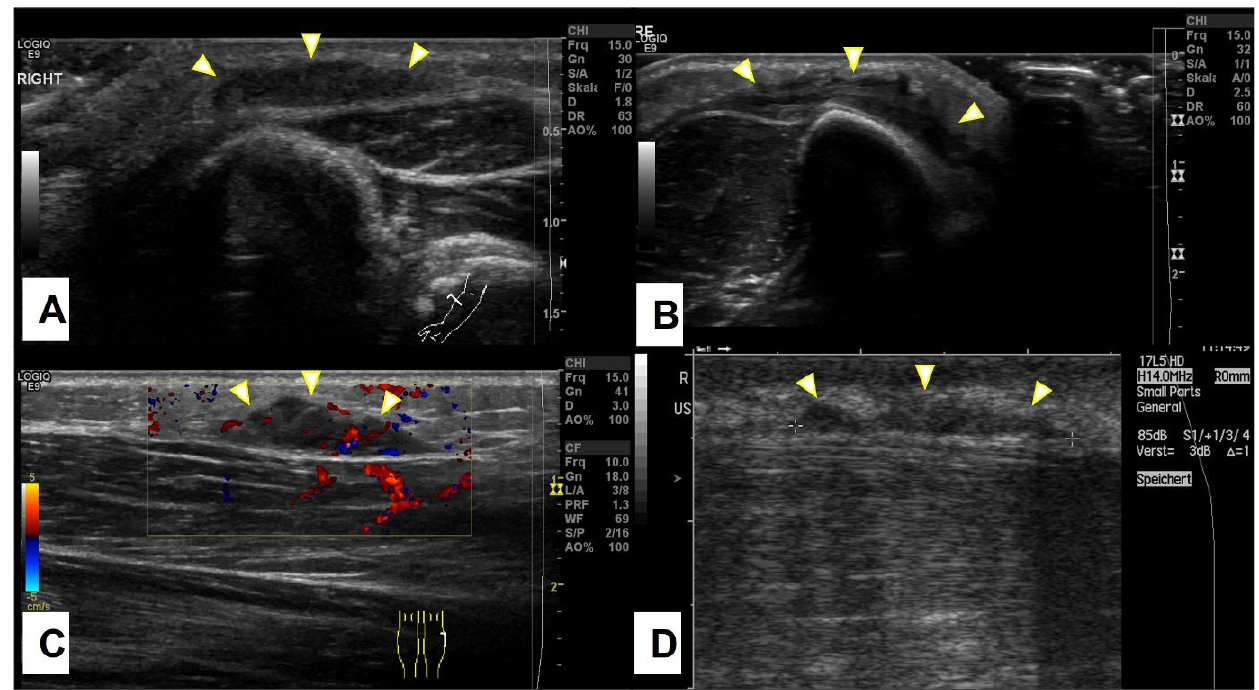
Figure 4. Representative slices of ultrasound imaging of subcutaneous granuloma annulare (SGA). The lesions are strictly epifascial with hypo- and hyper-echogenic zones and mild hypervascularization. A common finding is the cap shape of these lesions, marked with arrowheads. The depicted lesions were located on ( A ) the right forearm; ( B ) the right lower leg; ( C ) the left lower leg; ( D ) the right lower leg.